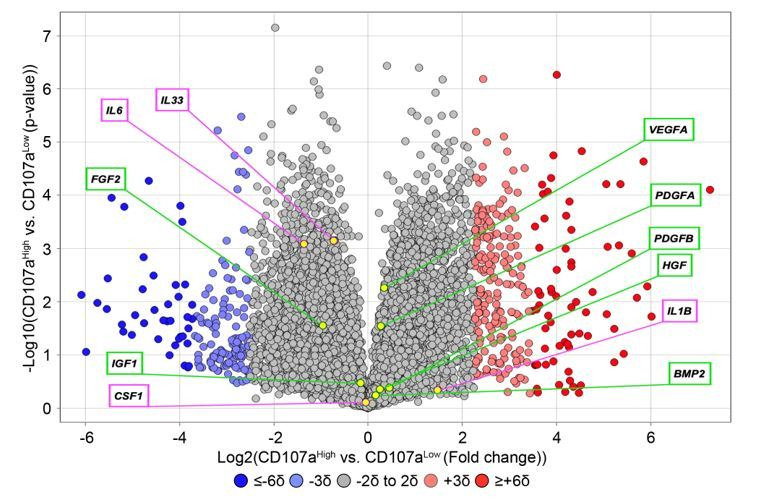
Expression of inflammatory cytokines and common growth and differentiation factors among human CD107alowCD31-CD45- and CD107ahighCD31-CD45- mesenchymal cells.Data shown in volcano plot. X-axis represents Log2 fold change for each gene. Y-axis represents -Log10 p value. Red dots indicate >2SD increase among CD107ahigh mesenchymal cells. Blue dots indicate >2SD increase among CD107alow mesenchymal cells. Inflammatory cytokines are shown in purple box, while growth factors are shown in green box.